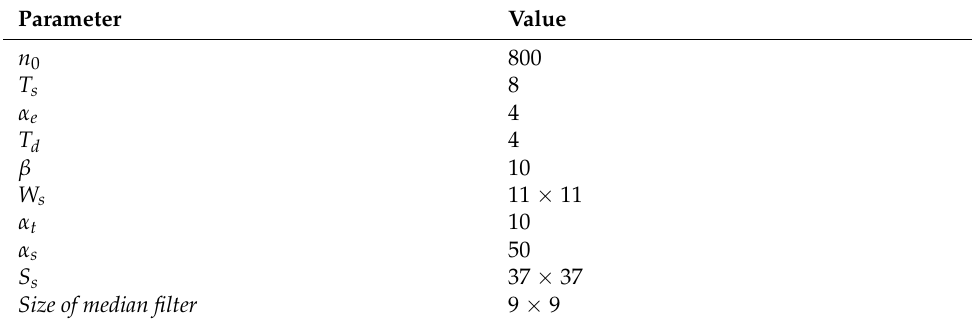
Table 1. Parameters used in